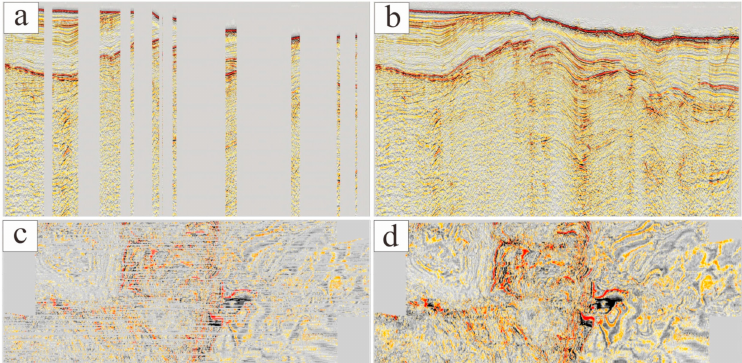
Figure 8. Comparison before and after five-dimensional interpolation (( a ). profile before interpolation; ( b ). profile after interpolation; ( c ). time slice before interpolation; ( d ). time slice after interpolation).